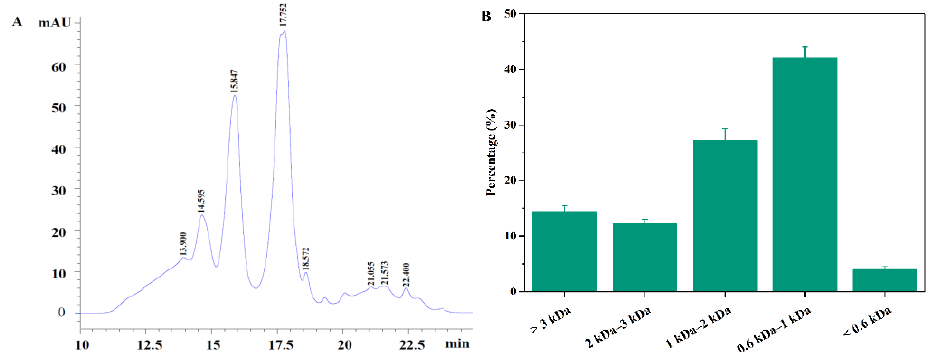
Figure 2. ( A ) HPLC elution of molecular weight and ( B ) molecular weight distribution of antifreeze peptides from defatted Antarctic krill